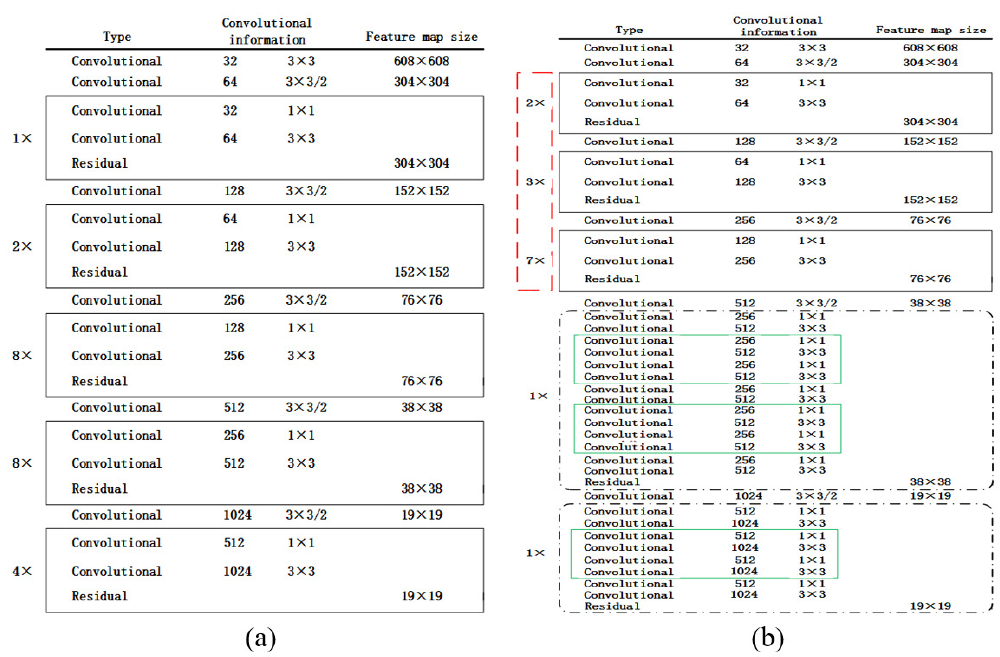
Figure 2. The backbone structure of YOLOv3 and UAV-YOLO. ( a ) Original YOLOv3 structure. ( b ) The proposed UAV-YOLO structure.